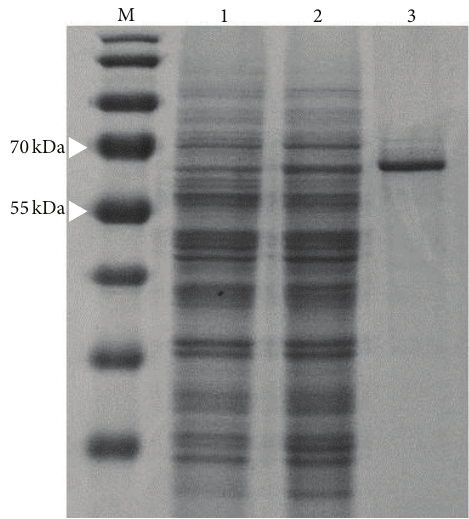
Figure 1: Analysis of S. cerevisiae cell lysates and purified PPV VP2 protein by SDS-PAGE. Lysates of S. cerevisiae harboring plasmids pFX7 (lane 1) and pFX7-PPV VP2 (lane 2) as well as CsCl-gradient purified PPV VP2 protein (lane 3) were separated in a 12% SDS-PAGE gel and stained with Coomassie Brilliant blue. PageRuler Prestained Protein Ladder (Fermentas/Thermo Fisher Scientific) was used as molecular mass standard in lane M.